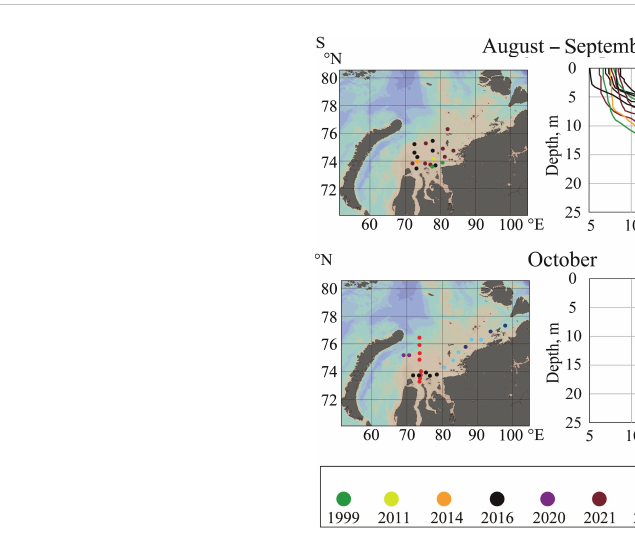
FIGURE 2 Typical vertical salinity structure in the Ob-Yenisei plume in August – September (A) and October (B) .